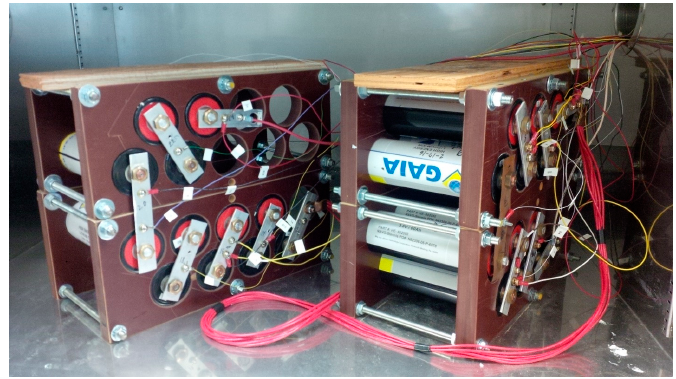
Figure 5. 24 cell GAIA battery pack.